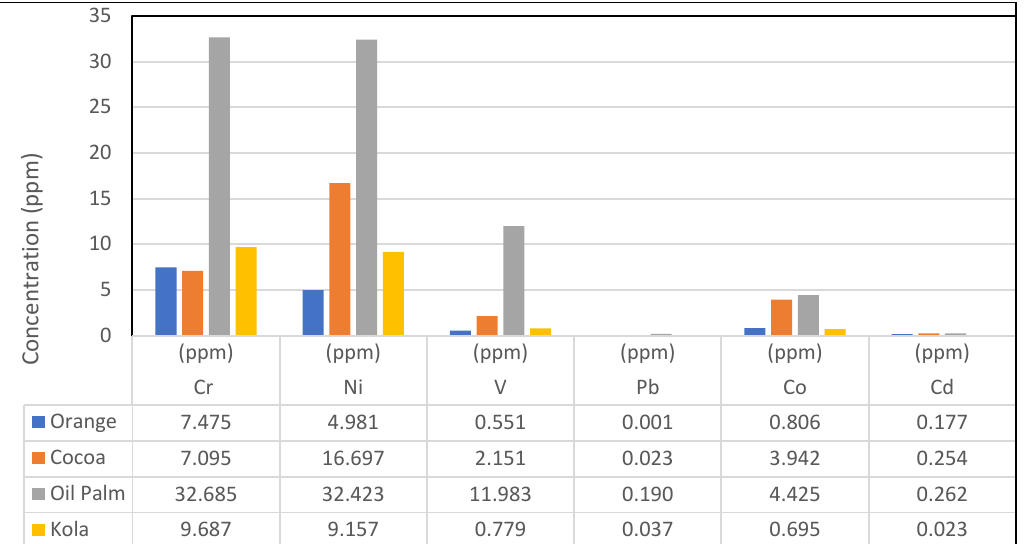
Figure 8. The concentration of Cr, Ni, V, Pb, Co, and Cd in the taproots of orange, cocoa, oil palm, and kola trees.